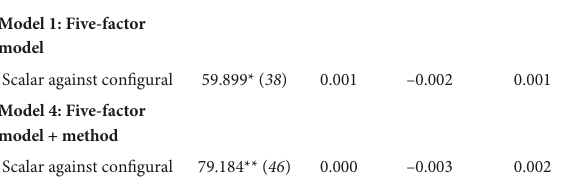
TABLE 3 Measurement invariance testing for the accepted models across sex.